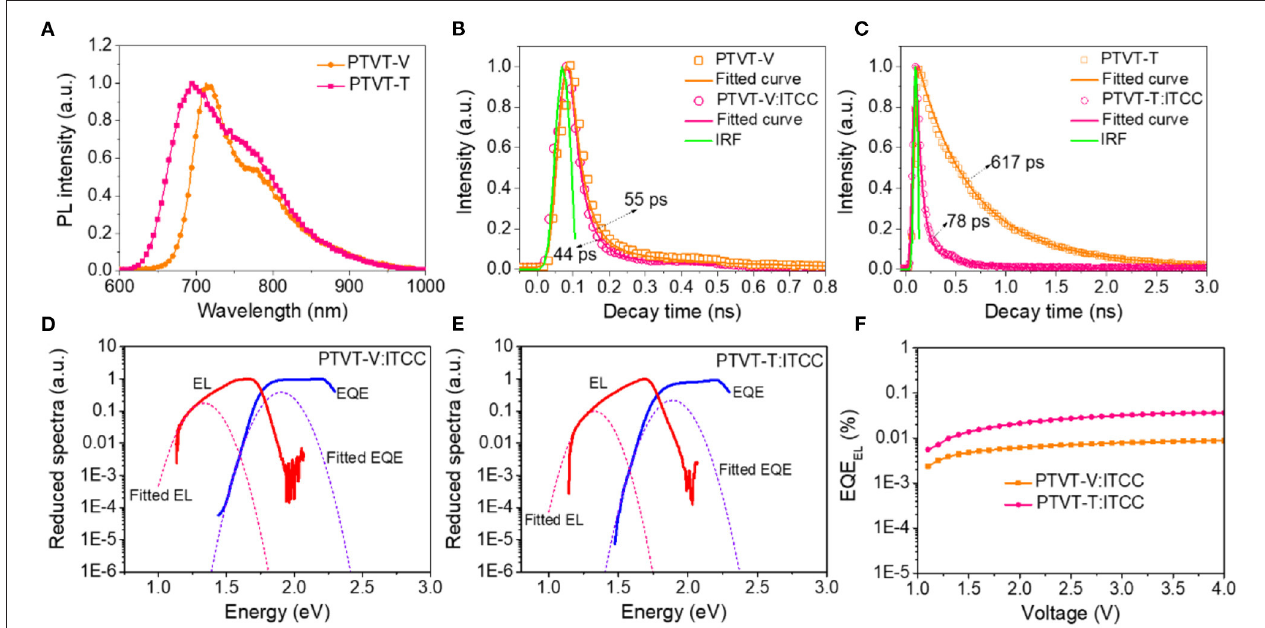
FIGURE 6 | (A) The steady-state PL spectra of PTVT-V and PTVT-T neat films with an excitation wavelength of 500nm. The PL decay kinetics of (B) PTVT-V based systems and (C) PTVT-T based systems. The determination of E CTs by EL and s-EQE spectra of (D) PTVT-V:ITCC and (E) PTVT-T:ITCC. (F) EQE EL of the devices based on PTVT-V:ITCC and PTVT-T:ITCC.